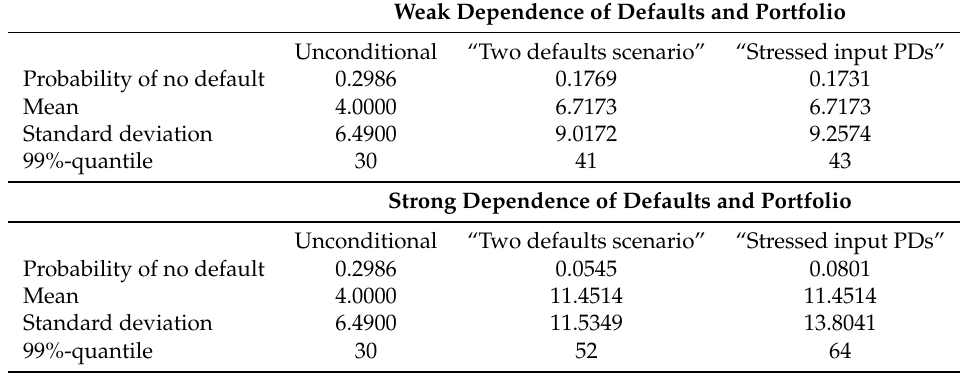
Table 2. Characteristics of unconditional, conditional on two defaults and “stressed input PDs” loss distributions of the portfolio described in Example 2. The model is two-factors CreditRisk +